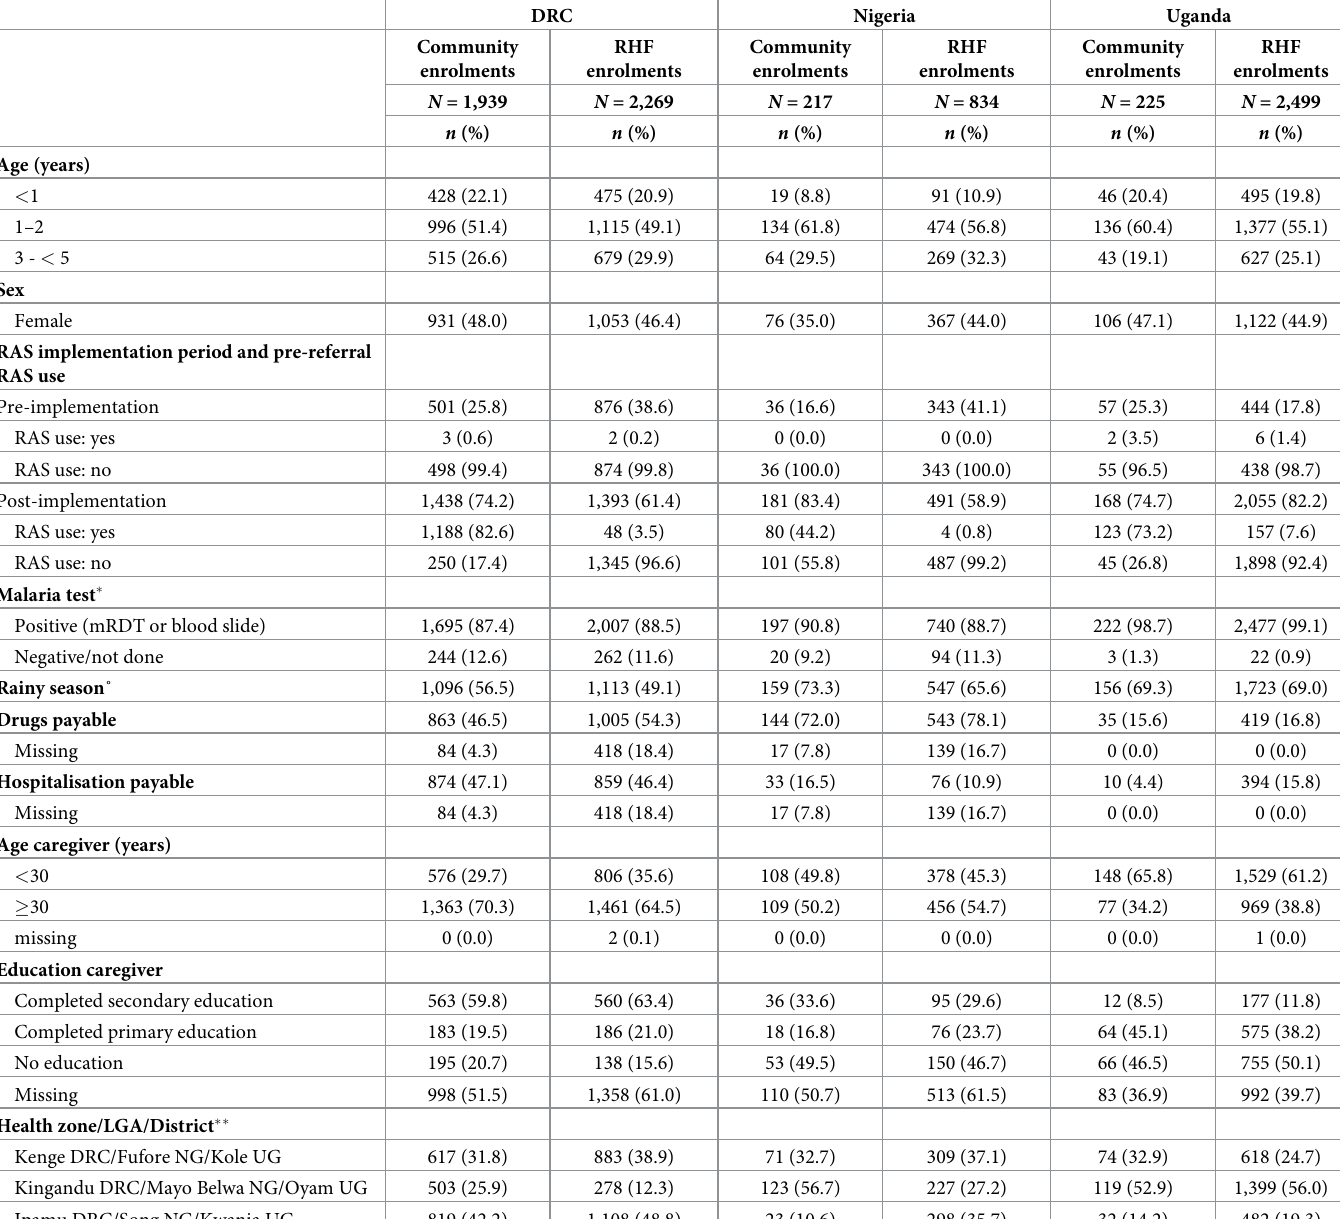
Table 1. Summary characteristics of surveyed patients and exposure variables.